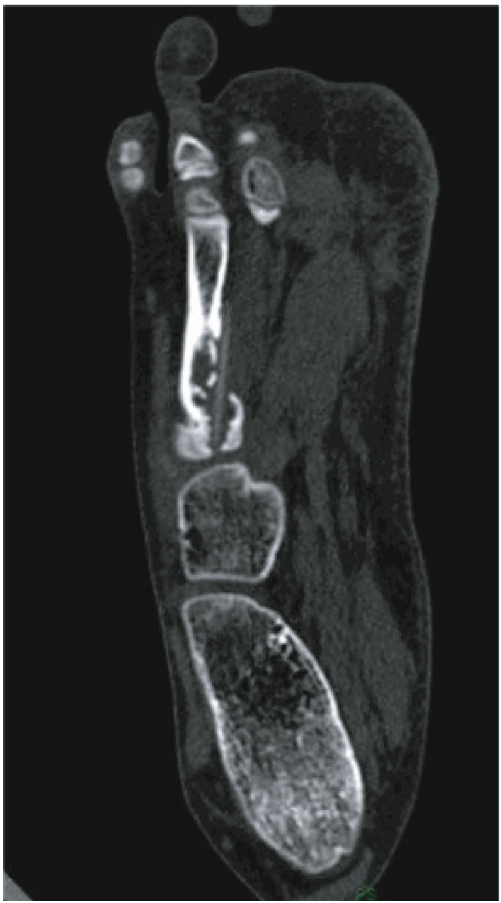
Figure 1: Transversal computed tomography key image with a linear hyperintense con fi guration, suggesting the presence of a foreign body.